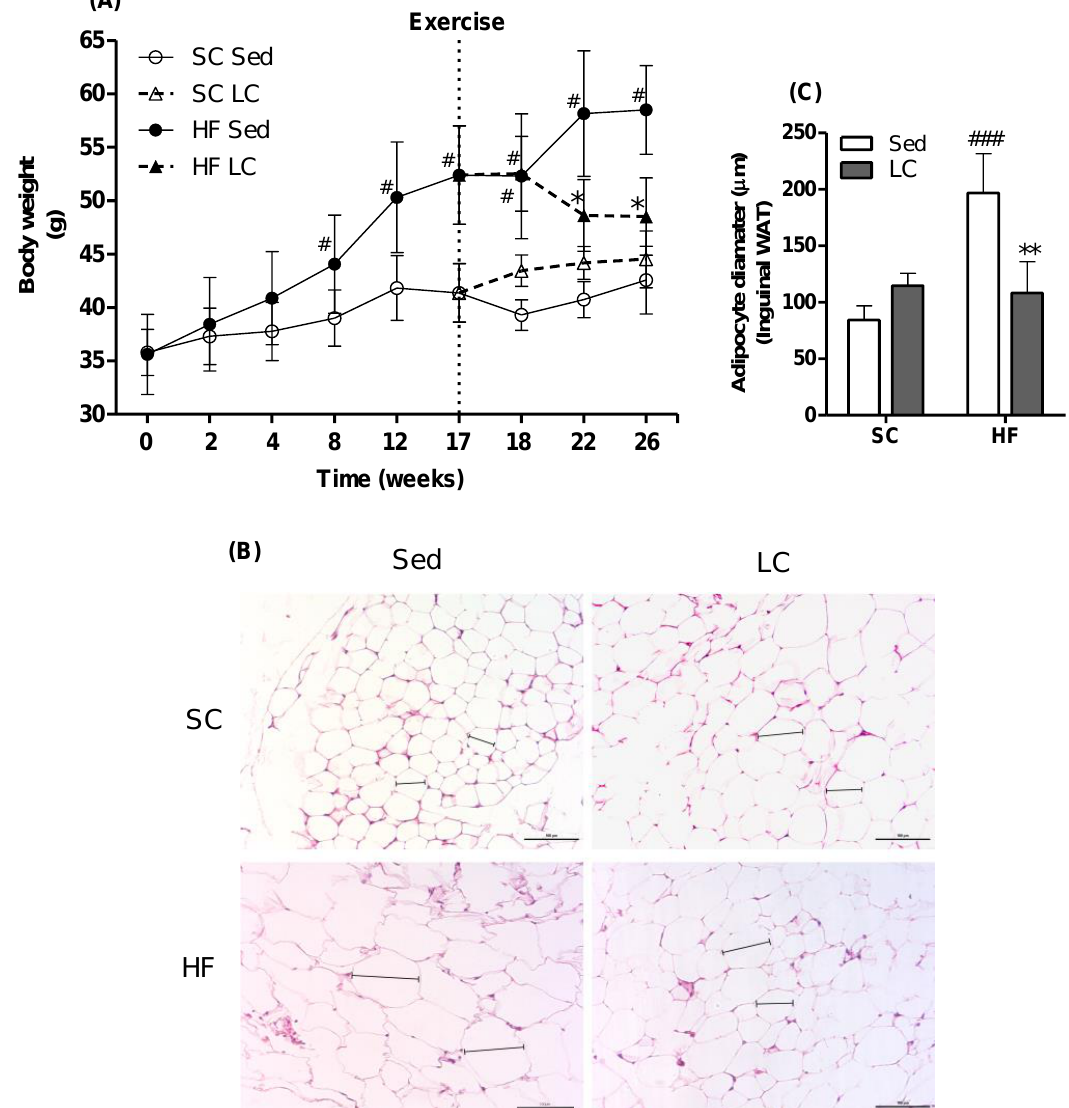
Figure 2. Effects of 17 weeks of HF feeding, followed by 8 weeks of LC on body weight ( A ) and white adipose tissue (WAT) ( B , C ). Two-way repeated-measures ANOVA with Bonferroni posthoc test (n = 5) ( A ). Representative images of histological photomicrographs of inguinal WAT (n = 3) ( B ). Two-way ANOVA with Bonferroni posthoc test. ( C ). * p < 0.05, ** p < 0.01 vs. respective sedentary (Sed); # p < 0.05, ### p < 0.001 vs. respective standard chow (SC) group.